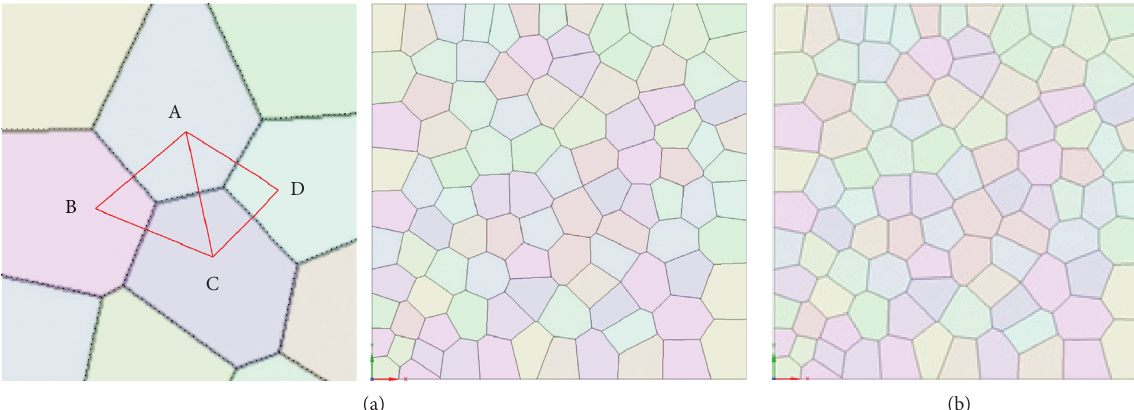
Figure 1: Two-dimensional particle and cell wall generation process.